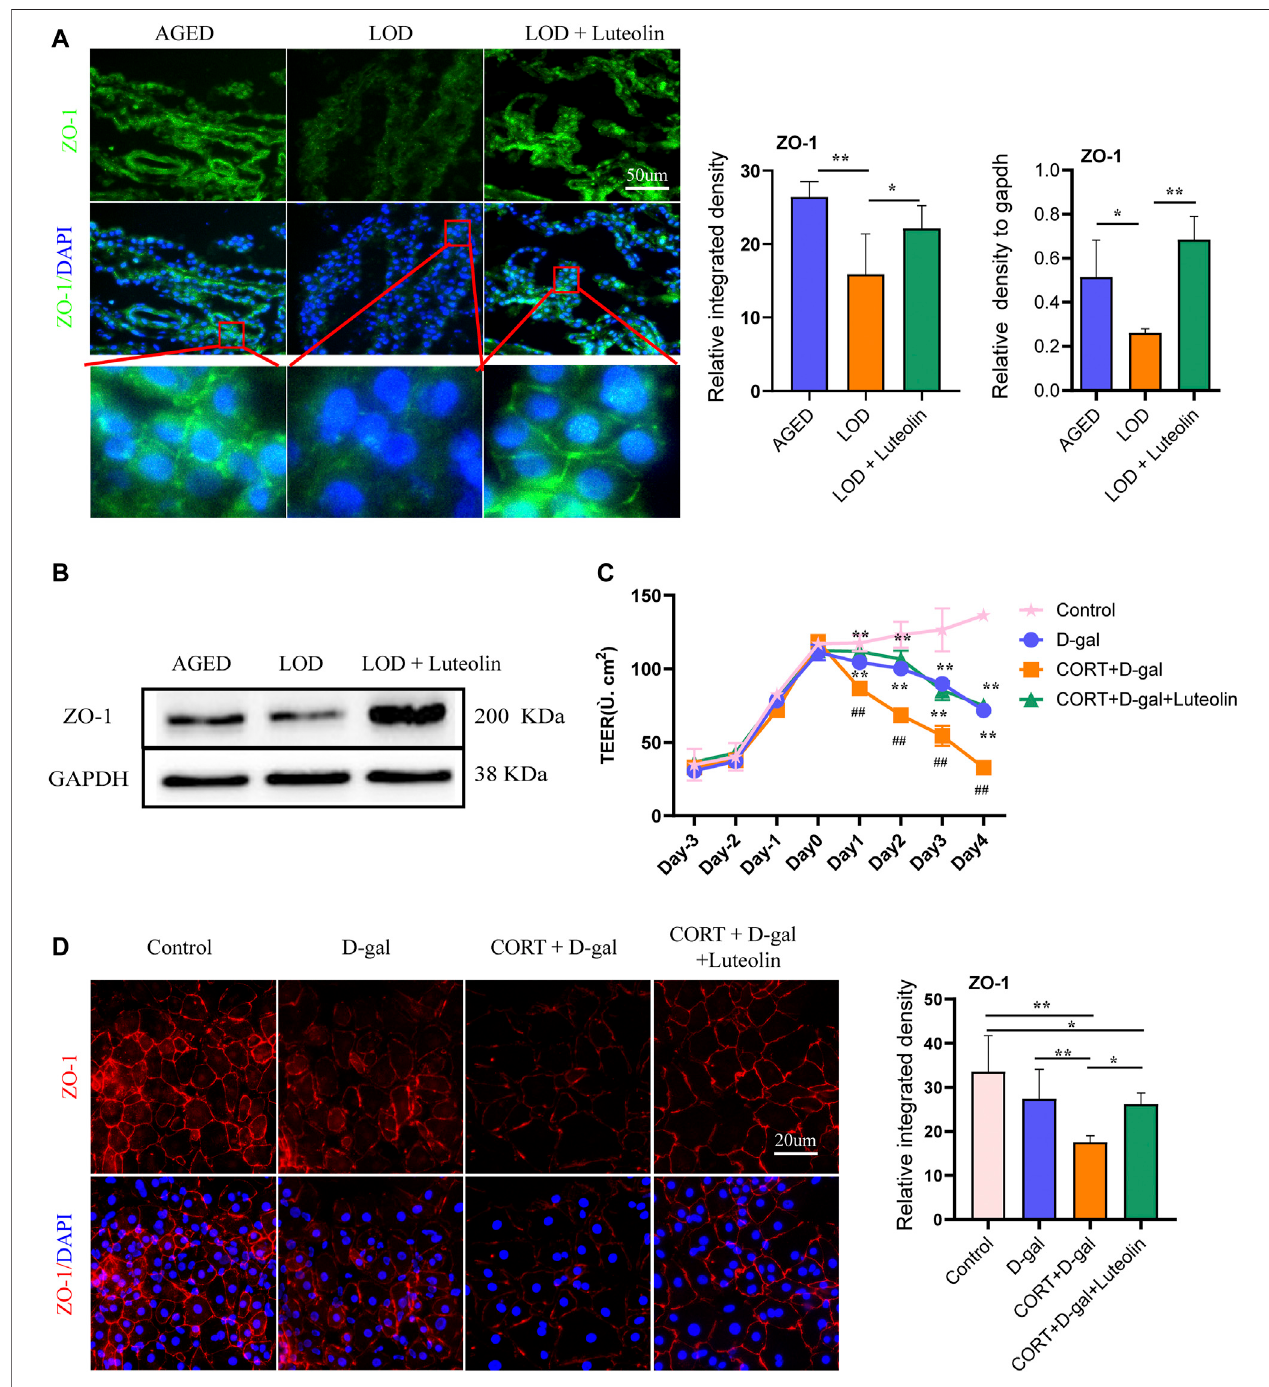
FIGURE 6 | Effects of luteolin on rat CP polarity and rat CPEC polarity. Representative immuno fl uorescence image of ZO-1 levels in the rat CP (A) and CORT + D-gal-inducedratCPECs (B) ( n =4).TEERofCORT+D-gal-inducedratCPECs (C) ( n =3).RepresentativeWestern blottingimagesofZO-1protein levelsintheCP( n = 4) (D) . Data in each group were consistent with a normal distribution (Shapiro – Wilk test) and exhibited homogeneity of variance; one-way analysis of variance was then used for comparisons. Data are expressed as the mean ± SEM, * p < 0.05, ** p < 0.01 vs. LOD or CORT + D-gal. # p < 0.05, ## p < 0.01, vs. Control.